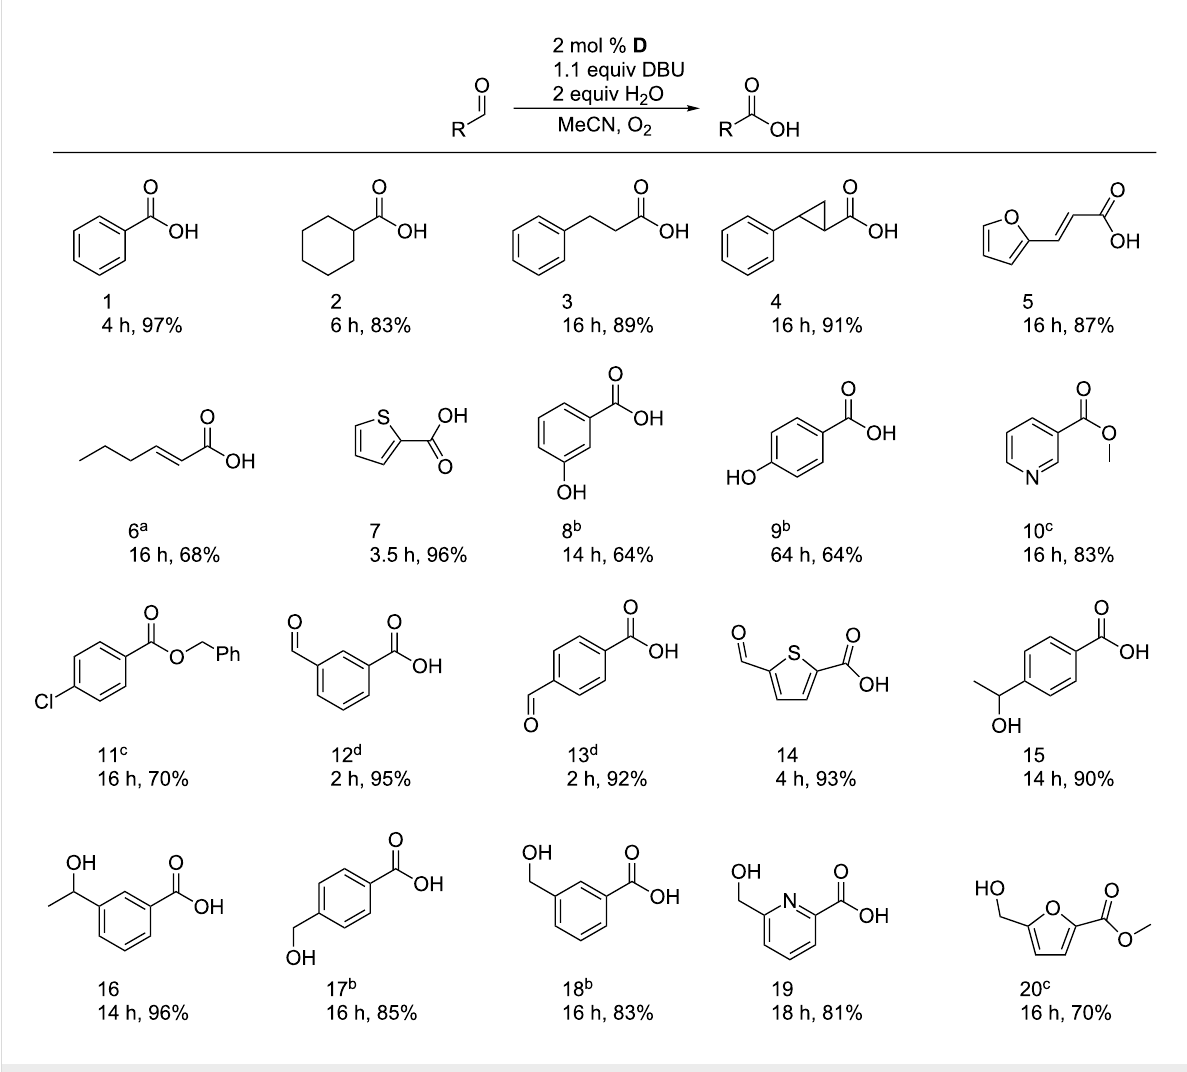
Figure 2: Oxidation of various aldehydes under the optimized conditions: a 2 equiv K 2 CO 3 was used instead of DBU; b 10 mol % of D was used; c 5 equiv of the corresponding alcohol were used instead of H 2 O; d 0.5 mol % of D was used. The data below the products refer to the reaction times and the yields of the corresponding